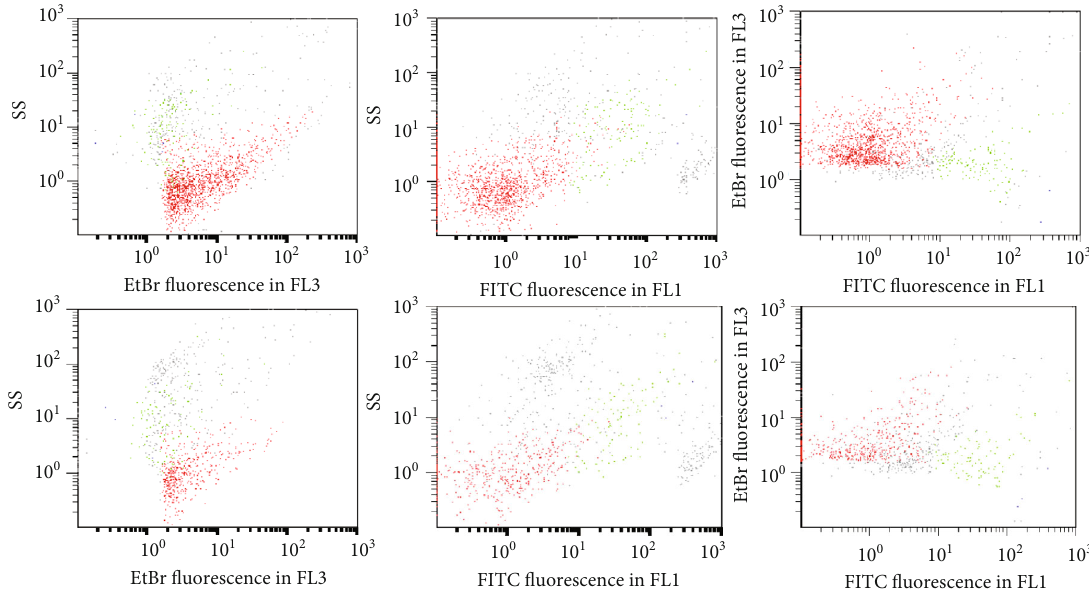
Figure 4: Control serum in the FCM test. In the upper histograms, control serum incubated with 20 μ g/ml ctDNA and in the lower histograms before incubation. Unlike SLE serum samples, no IC-DNA was